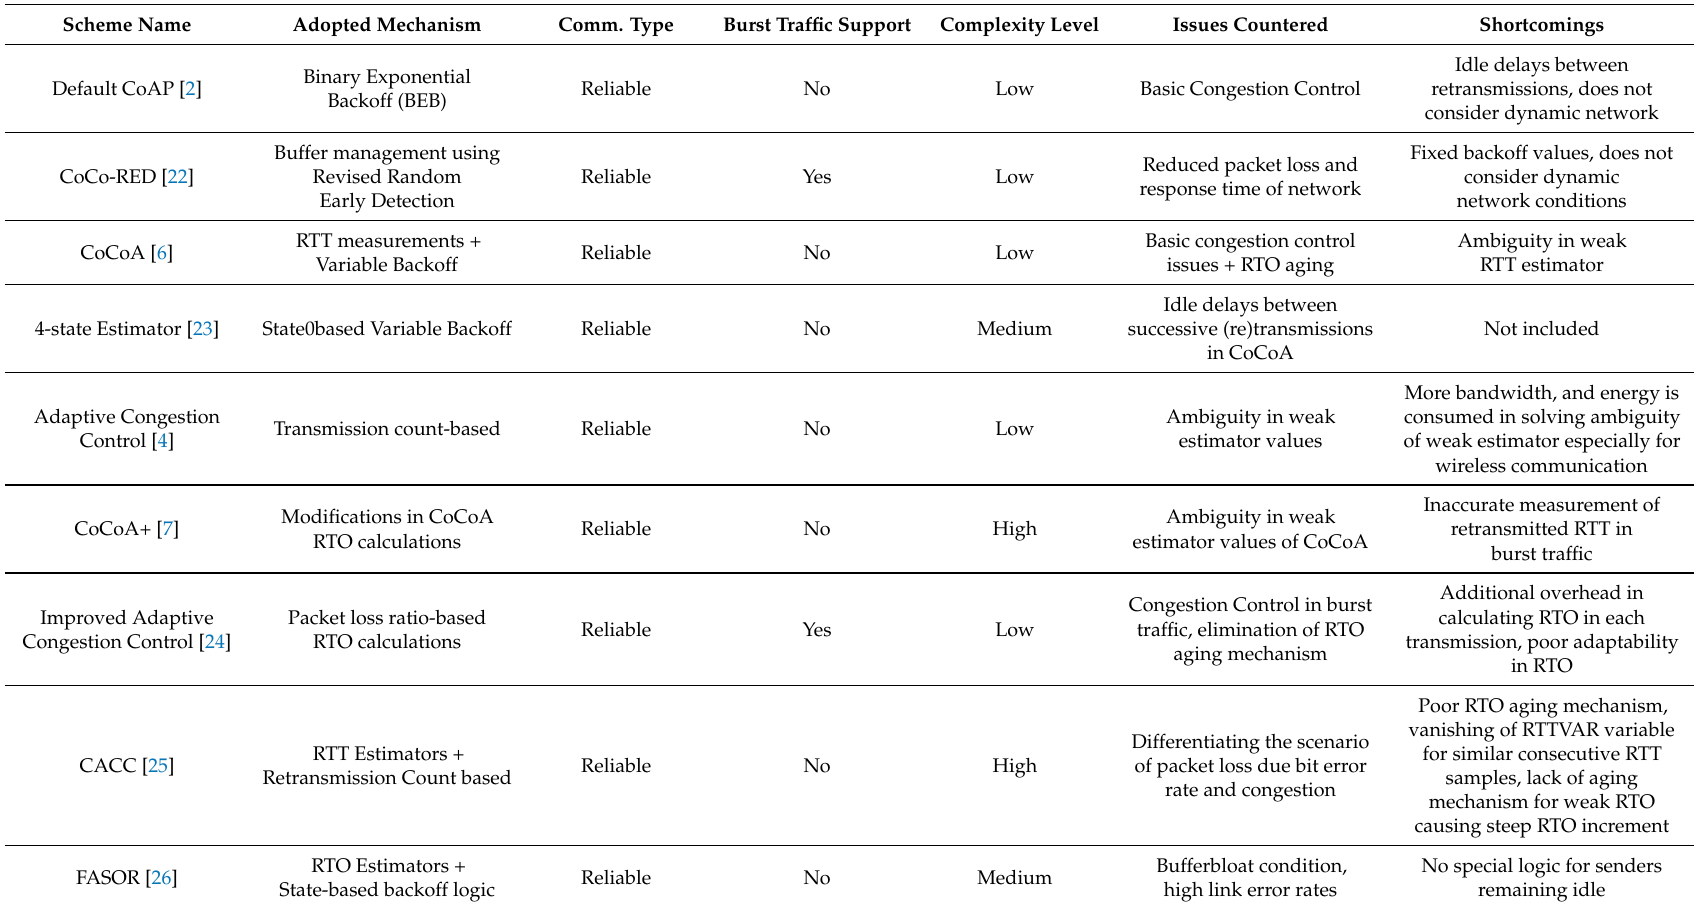
Table 2. Comparison of Congestion Control